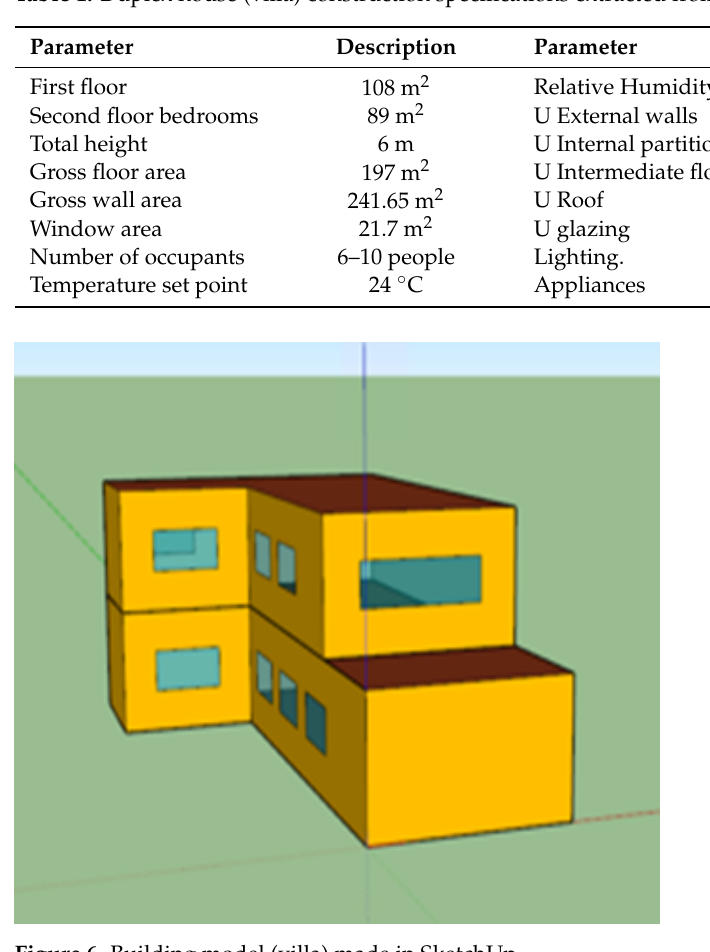
Figure 6. Building model (villa) made in SketchUp.